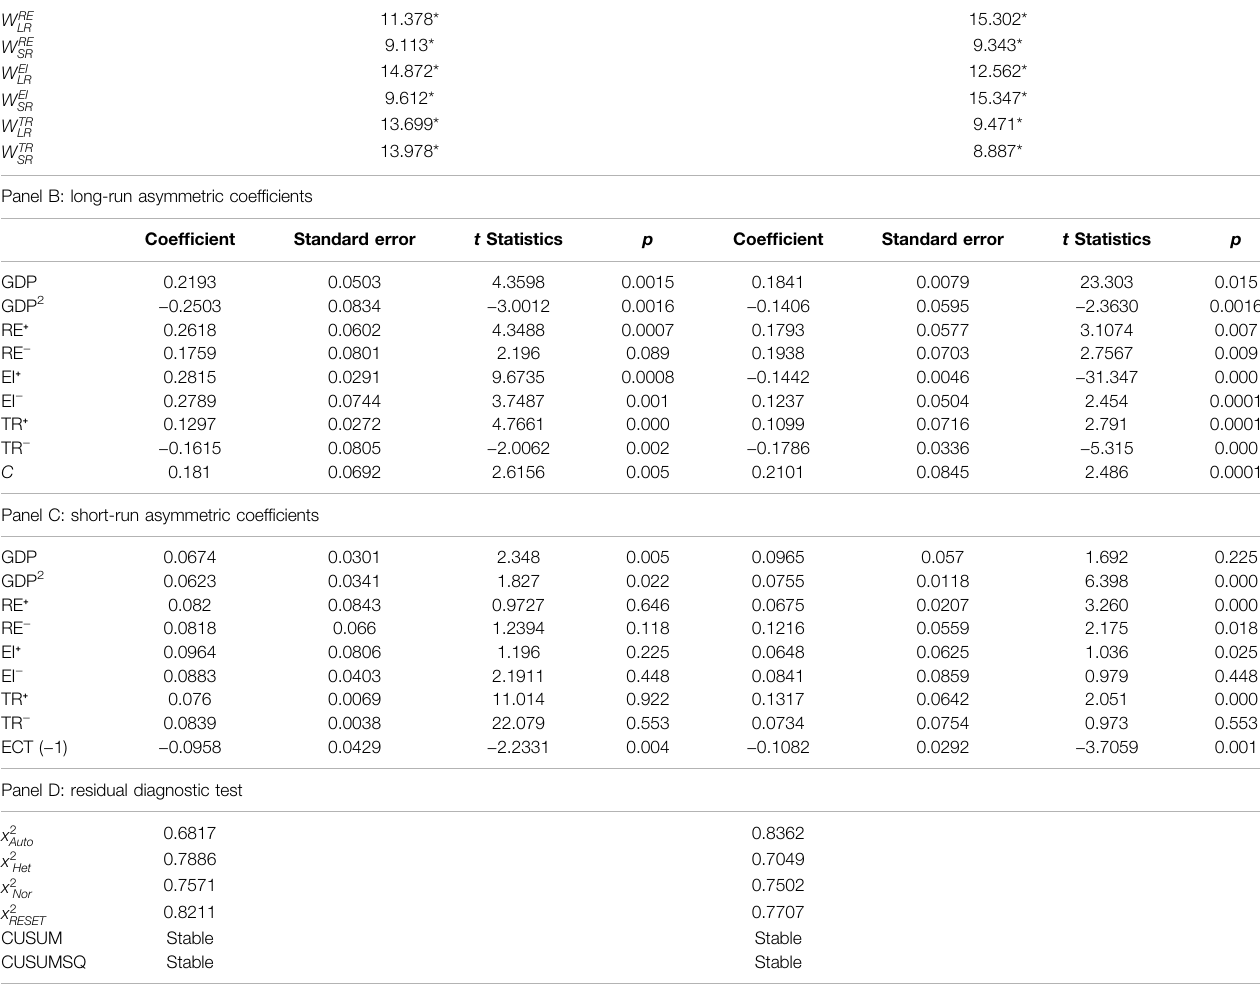
Panel — A: long- and short-run symmetry